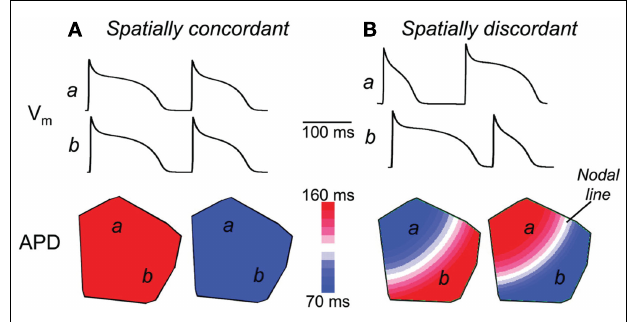
FIGURE 4 | Spatially concordant and discordant alternans in simulated cardiac tissue. Shown are the results of rapidly pacing a 2-dimensional homogeneous sheet of simulated cardiac tissue (from the top left corner), including the spatial distribution of action potential durations (bottom) and the action potentials occurring at two sites in the tissue (top traces). (A) During pacing at a cycle length of 220ms, spatially concordant alternans is seen, in which the APD of all myocytes alternate in-phase. (B) Pacing at a cycle length of 180ms, however, induces spatially discordant alternans, in which the action potentials of adjacent regions of tissue alternate out-of-phase.This is seen in the top traces, where the action potentials of site a alternate short-long at the same time as those of site b alternate long-short . As seen in the bottom panel, this spatially discordant alternans causes a large gradient in APD across the tissue, with large regions of tissue with counter-phase APD-alternans, separated by a “nodal line” where alternans is not seen (and where the APD gradient is steepest). Adapted fromWeiss et al. (2006).